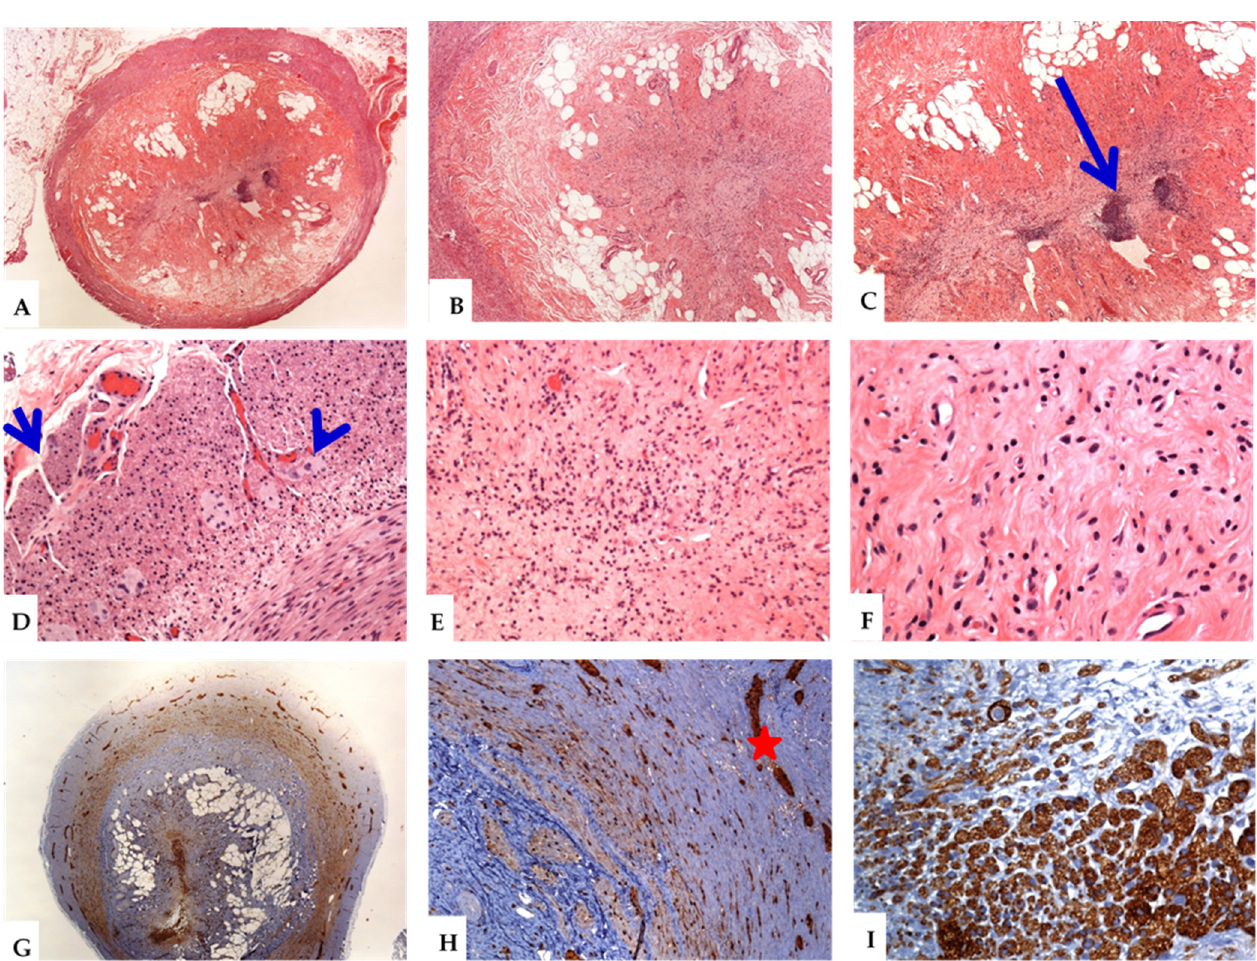
Figure 2. The histological features of the central variant of neurogenic appendicitis (neuroma of the appendix). Different magnifications of the appendix reveal obliteration of the lumen, effacement of the appendiceal micro-architecture, with loss of the mucosal glands and the lymphoid follicles ( A – F ). There is an obliteration of the lumen by residual reactive lymphoid aggregates (long arrow), and varying proportions of nerve tangles, fibrous tissue, collagen, fat, and chronic inflammatory cells ( A – C ). The presence of residual lymphoid cells is indicative of repeated attacks of minimal asymptomatic mucosal inflammation. Hypertrophied nerve bundles (short arrow) and ganglion cells ( D : arrowhead) are noted. The neuronal component is composed of mitotically inactive cells, with spindly nuclei and pale cytoplasm (Schwann-like cells) obliterating the lumen and expanding the lamina propria ( E , F ). The hypertrophied myenteric plexuses ( G ) and nerve fibers ( H , I ) are stained with antibodies against S100 ( H : red star). Synaptophysin immunostain decorates the prominent nerve plexuses, fibers, and ganglion cells ( I ). (Original magnifications, A : ×20, B : ×40, C : ×100, D : ×200, E : ×200, F : ×400, G : ×20, H : ×200, and I : ×400).